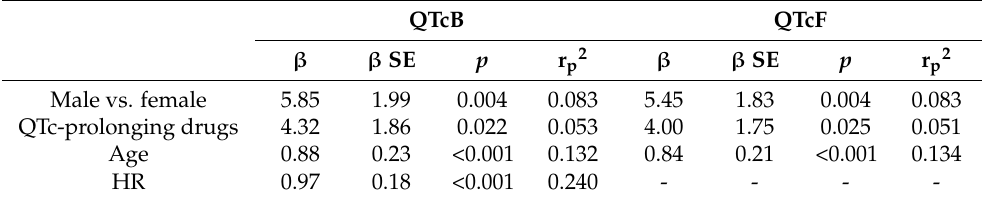
Table 5. Final regression models for QTcB and